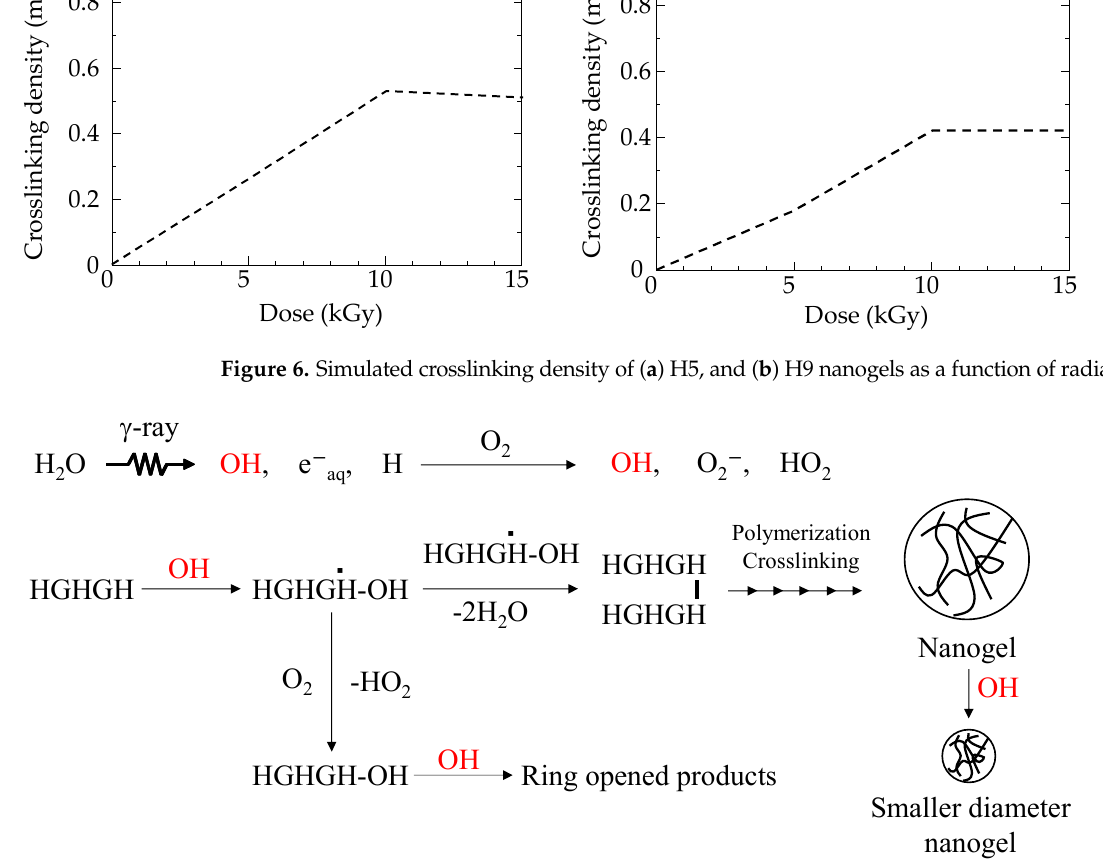
Scheme 1. Peptide nanogel formation in water via radiation